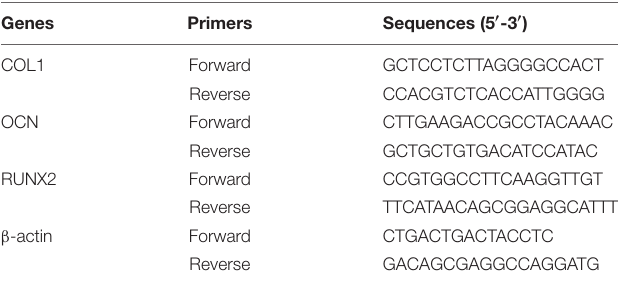
TABLE 1 | Sequences of primers used for real-time